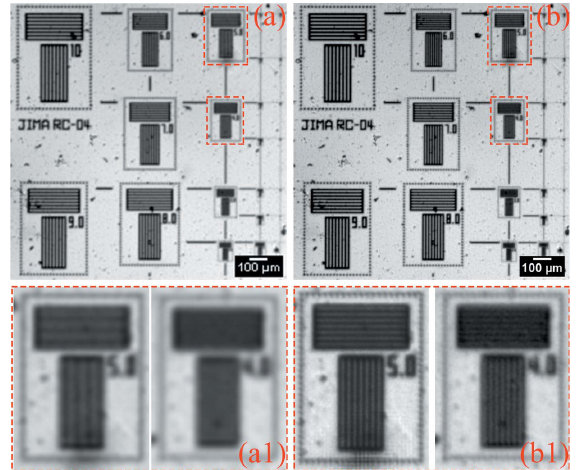
Figure 15 Experimental results verifying the effect of the projection SNR on the micro-scanning method. ( a ) The projection of low SNR (pixel size: 6.5 m m (cid:2) 6.5 m m; pixel number: 230 (cid:2) 230). ( b ) The oversampled image with deconvolution of low SNR (pixel size: 3.25 m m (cid:2) 3.25 m m; pixel number: 460 (cid:2) 460). Panels ( a ) and ( b ) are only part of the image to show the details more